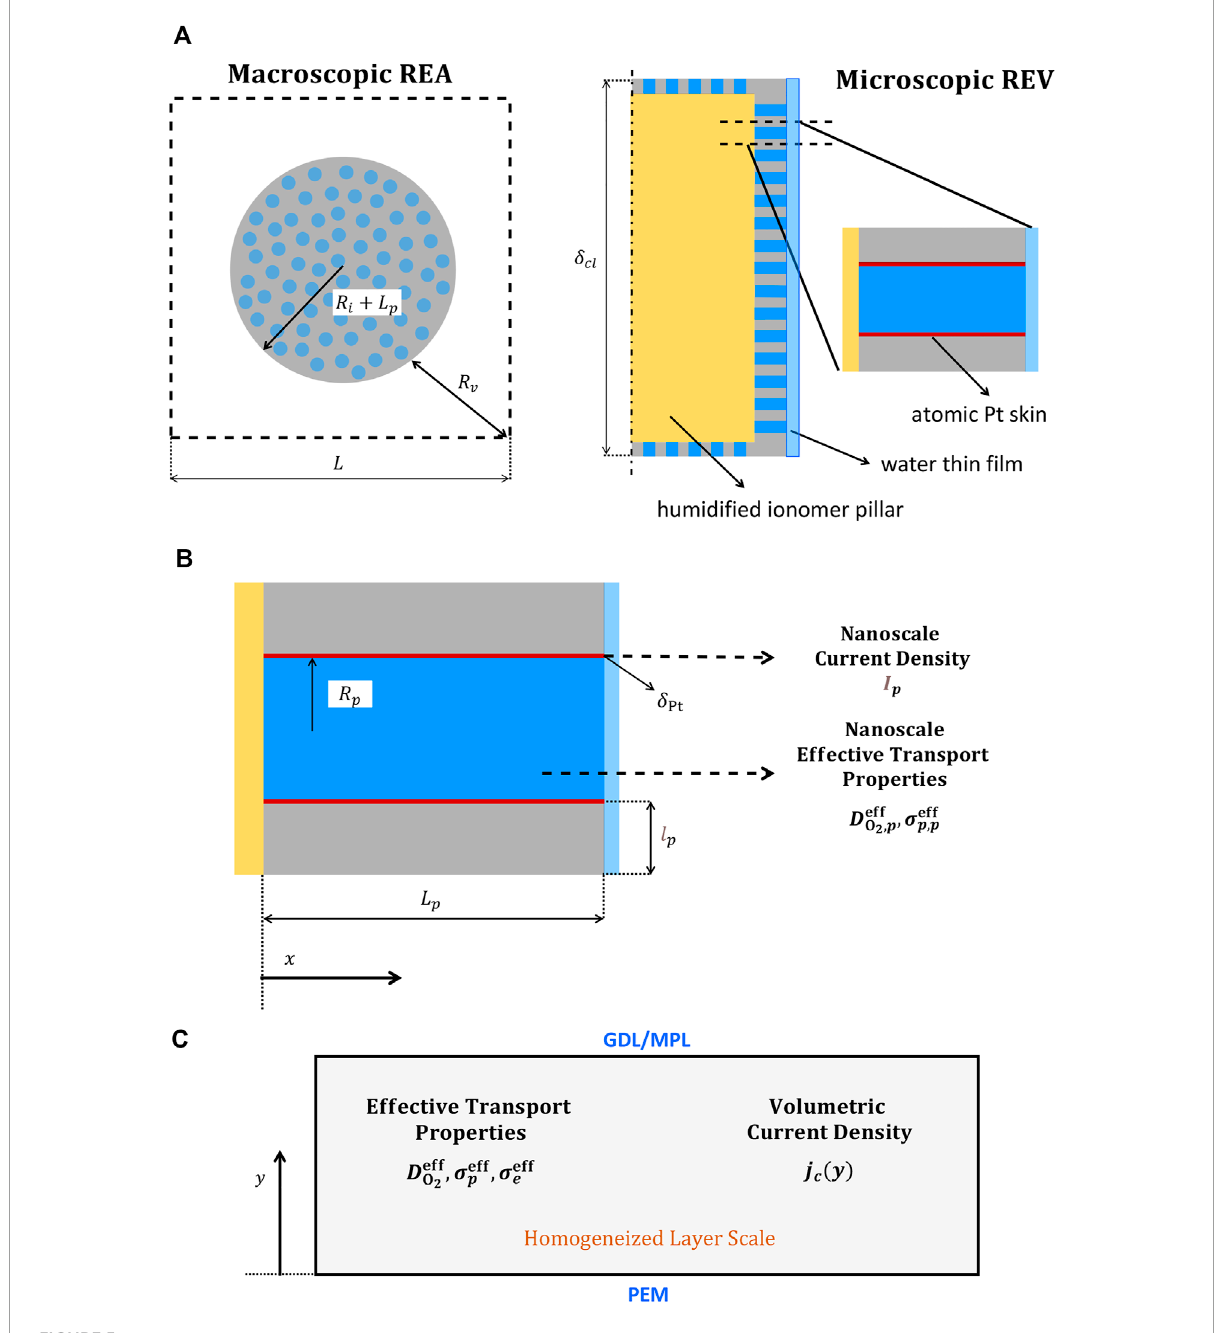
FIGURE 5 (A) REA of the examined bi-functionalized bimodal CL composed of cylindrical ionomer pillars surrounded by a nanoporous shell catalyzed with an atomic Pt skin. (B) Close-up view of the nanoscale geometry between an ionomer pillar and the secondary pore space. (C) Macro-homogenized representation of the CL at the layer scale with composition-dependent effective transport properties and volumetric current density determined from the microscopic model at the